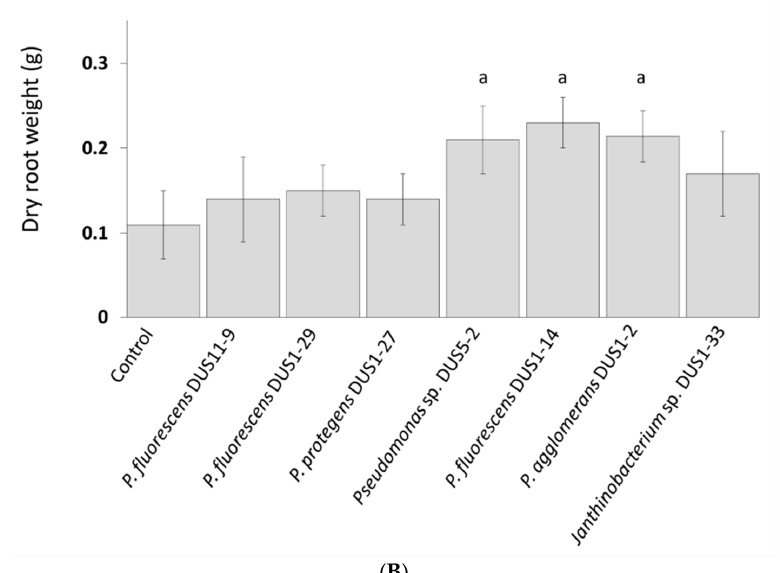
Figure 5. Effect of bacterial isolates on plant shoot ( A ) and root ( B ) biomass after 91 days in a glasshouse system with media (soil) maintained at 8% water activity. For inoculated plants, 1 × 10 3 CFU of each strain were added when seeds were sown. Five biological replicates (five pots) with five technical replicates (five plants per pot) were set up and grown for 91 days for each treatment group. Significantly ( p < 0.05) increased dry shoot ( A ) and dry root ( B ) biomass of inoculated plants compared to uninoculated control plants are denoted by an ”a”.